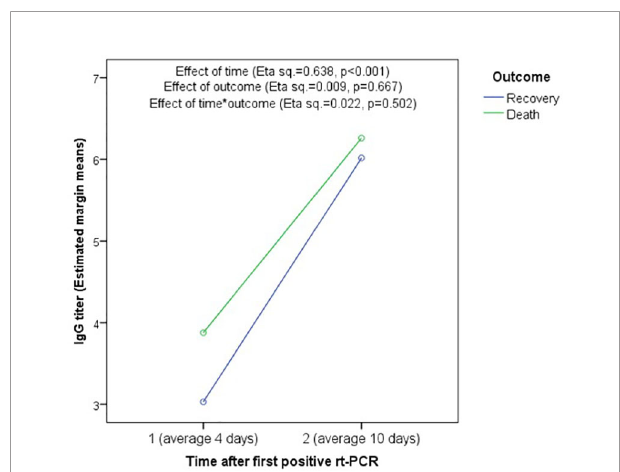
FIGURE 3 | Association between mortality and change in IgG titer using Repeated-measure ANOVA. There is no signi fi cant association of IgG titer with outcome (Eta squared = 0.009, p = 0.667) or time*outcome (Eta squared = 0.022, p = 0.502). However, the effect of time was signi fi cant showing signi fi cant increase in IgG titers between the fi rst and second testing in both recovered and deceased